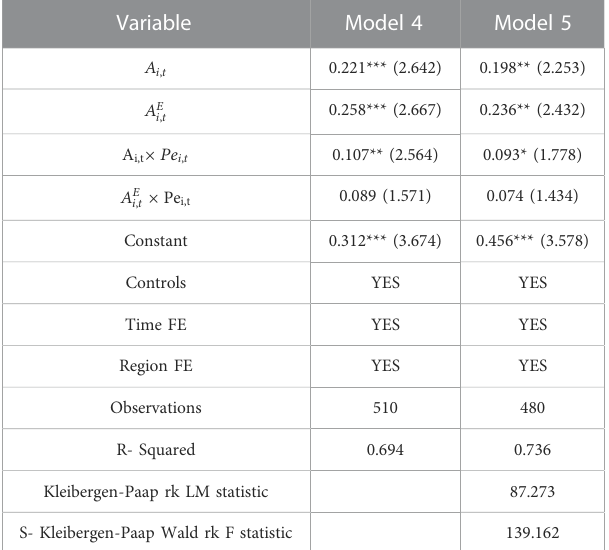
TABLE 11 Results of the fi rst mechanism test in China ’ s service industry. TABLE 12 Results of the second mechanism test in China ’ s service